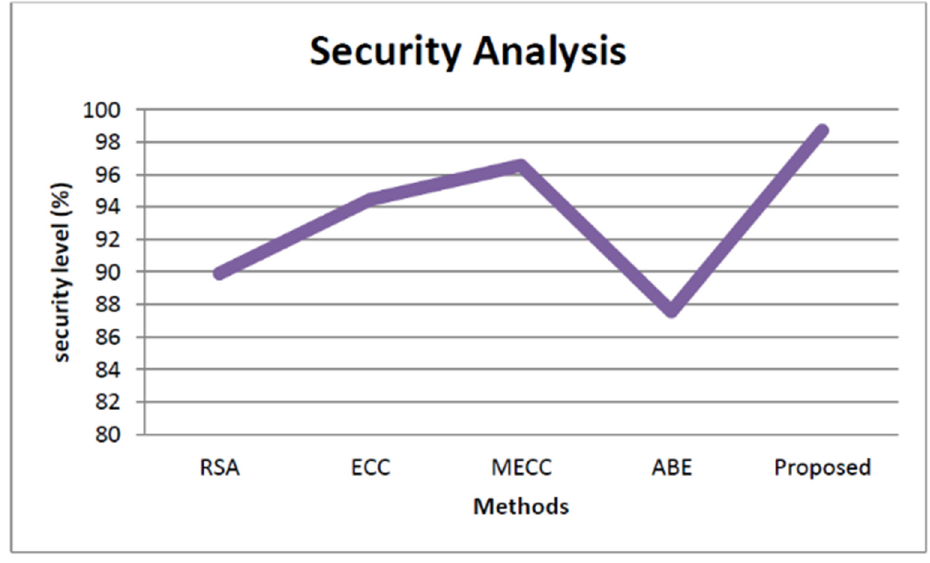
Figure 7. Storage security analysis based on the security level.